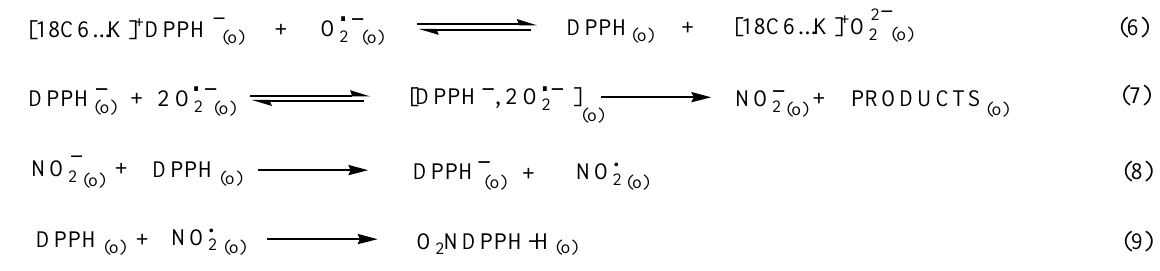
Table 2. Quantitative TLC data on the reactions of DPPH ( 1a ) with HO